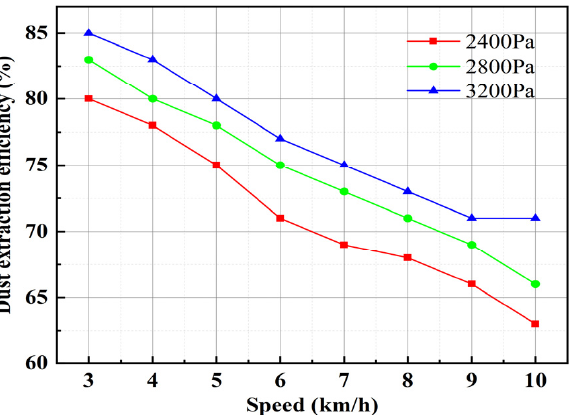
Figure 7. Simulation results of dust extraction efficiency at different driving speeds and negative pressures.